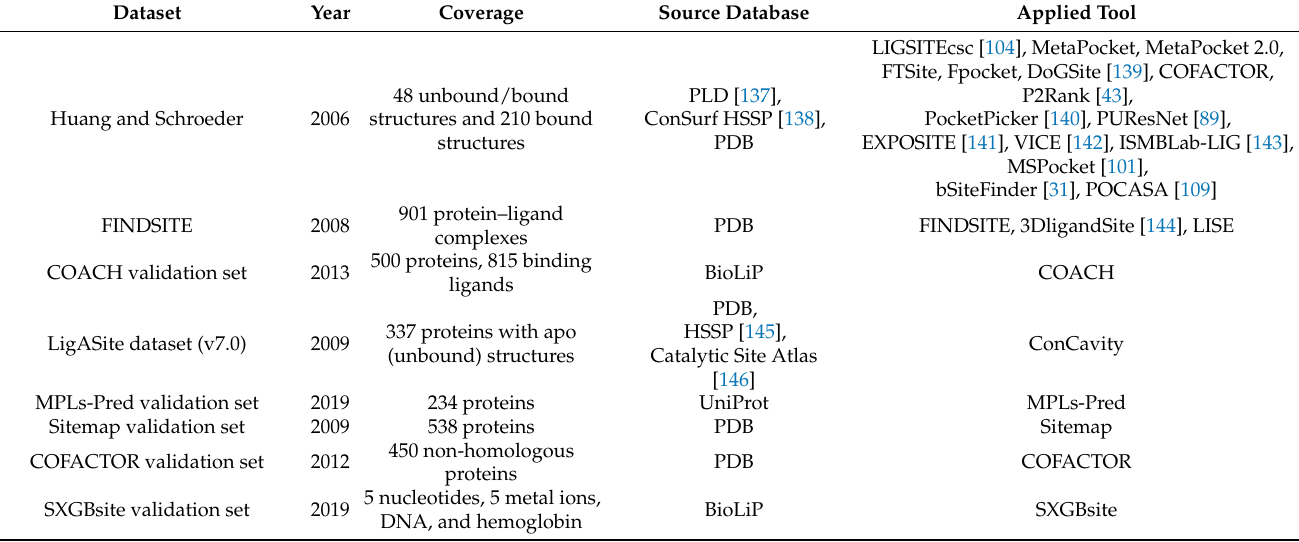
Table 6. Benchmark datasets with different tools for the identification of binding